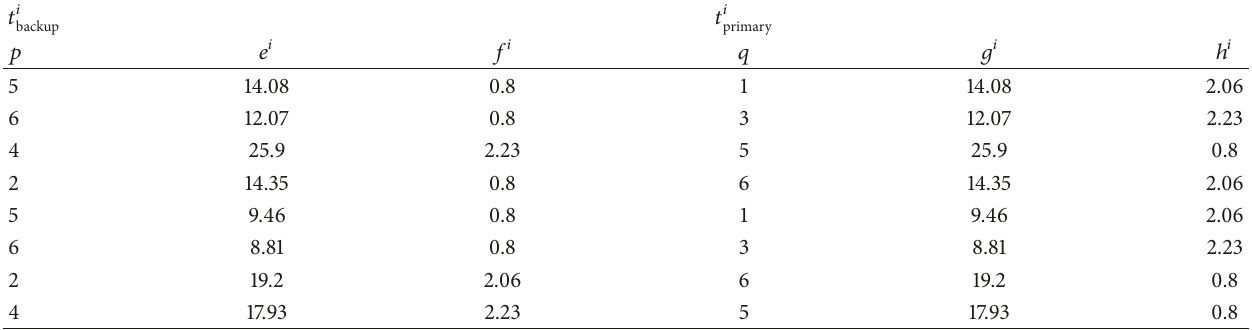
Table 8: Values of constants 𝑒 𝑖 , 𝑓 𝑖 ,𝑔 𝑖 , and ℎ 𝑖 for Model I.